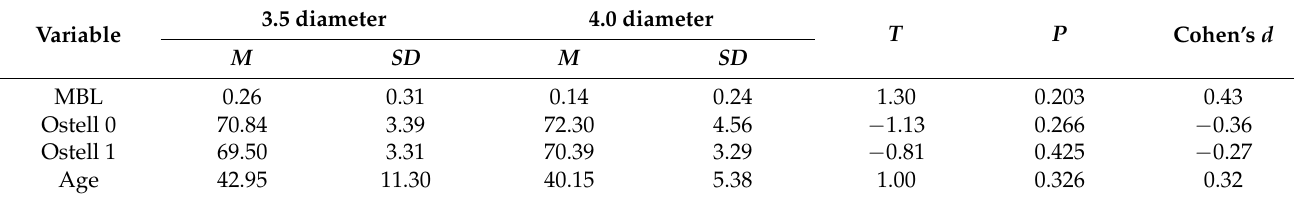
Table 6. The Student’s t-test results for a grouping variable (diameter) and selected dependent variables.